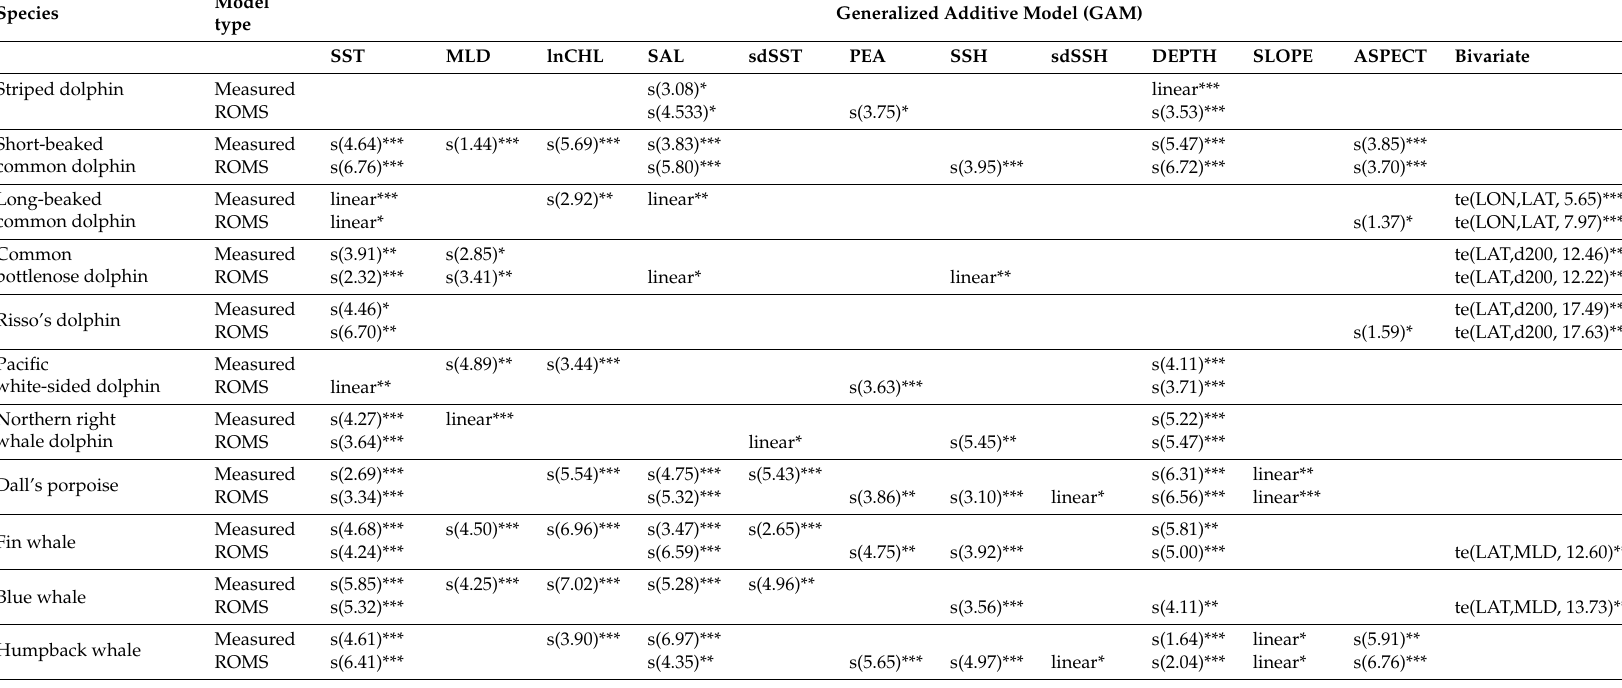
Table 1. Summary of the final encounter rate (delphinids) or single response (Dall’s porpoise and large whales) Generalized Additive Models (GAMs) built with either measured data or Regional Ocean Modeling System (ROMS) output. Terms are represented as smoothing spline functions with associated effective degrees of freedom to indicate the level of smoothing (e.g., s(3.24)) or linear terms (“linear”). A tensor product smooth is represented as “te” with the bivariate terms and associated effective degrees of freedom (e.g., te(LON,LAT, 7.97)). Variable abbreviations are as follows: SST = sea surface temperature, MLD = mixed layer depth, lnCHL = ln(chlorophyll concentration), SAL = sea surface salinity, sdSST = standard deviation of SST, PEA = potential energy anomaly, SSH = sea surface height, sdSSH = standard deviation of SSH, DEPTH = bathymetric depth, SLOPE = bathymetric slope, ASPECT = slope direction, d200 = distance to the 200-m isobath, LON = longitude, and LAT = latitude. p -values are indicated with *** (<0.001), ** (<0.01), and * (<0.05). All models were corrected for effort with an offset for the effective area searched, and both fin whale models also included a year covariate that captured their increase in abundance during the 1991–2009 survey years (see text for